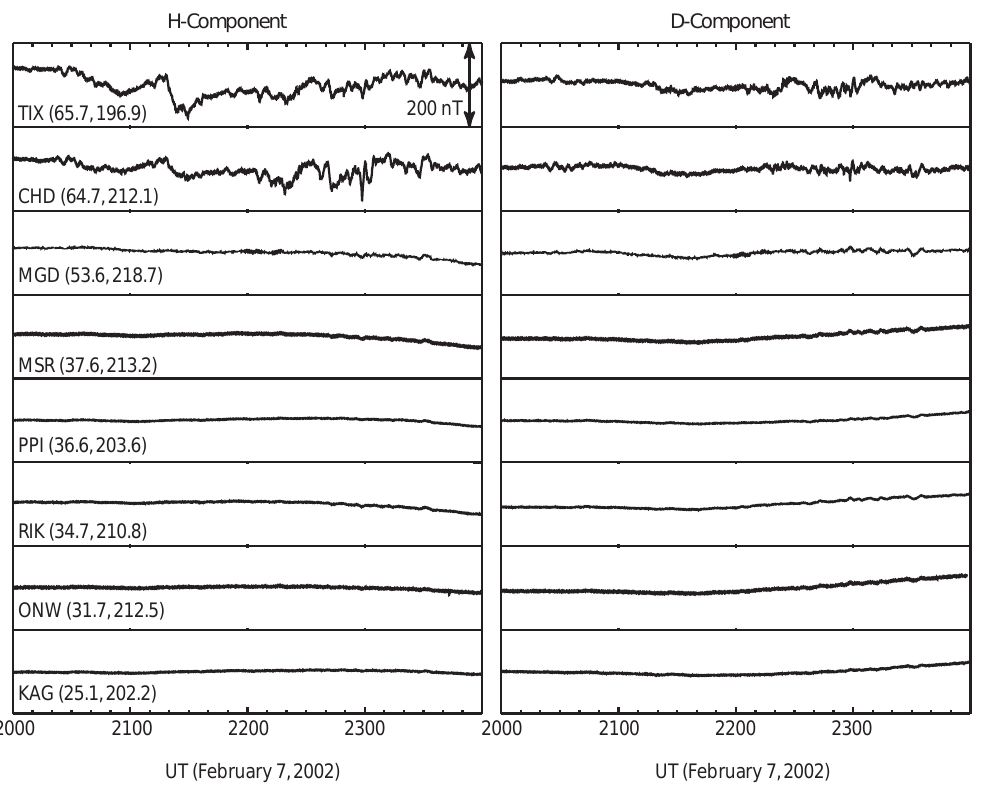
Fig. 12. The stacked horizontal components ( H and D ) of the magnetic field from the 210-MM array stations in the Asia/Pacific sector for a 4-h period from 20:00 to 24:00 UT. In each right panel, the numbers next to the station name give the CGM latitude and longitude of the